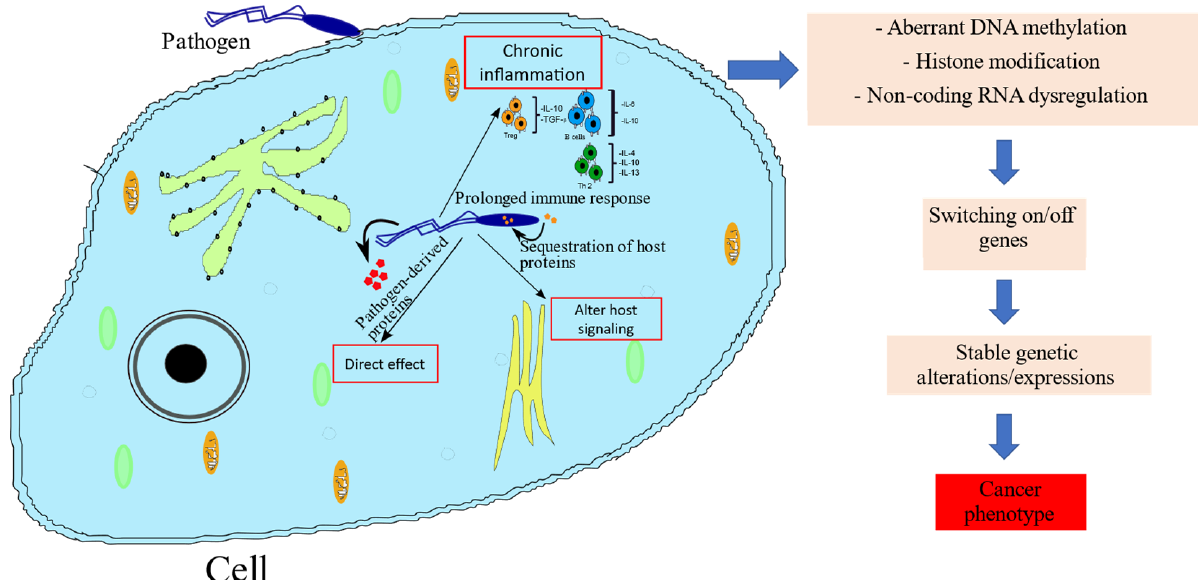
Figure 2. Schematic of mechanisms by which pathogens induce cancer-mediating epigenetic modifications. Upon entry into a cell, a pathogen may release pathogen-derived factors directly into the cytoplasm, alter host inflammatory responses and/or sequester host proteins. These events may lead to epigenetic changes, which stably alter the host genetic expression pattern, potentially leading to carcinogenesis.